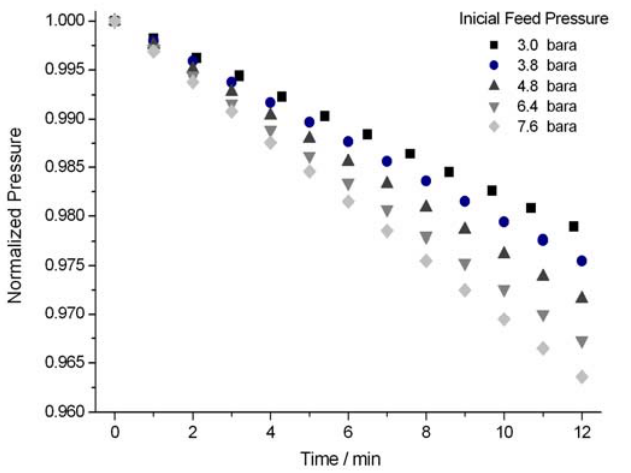
Figure 2. Feed pressure drop normalized by the pressure gradient across the ice